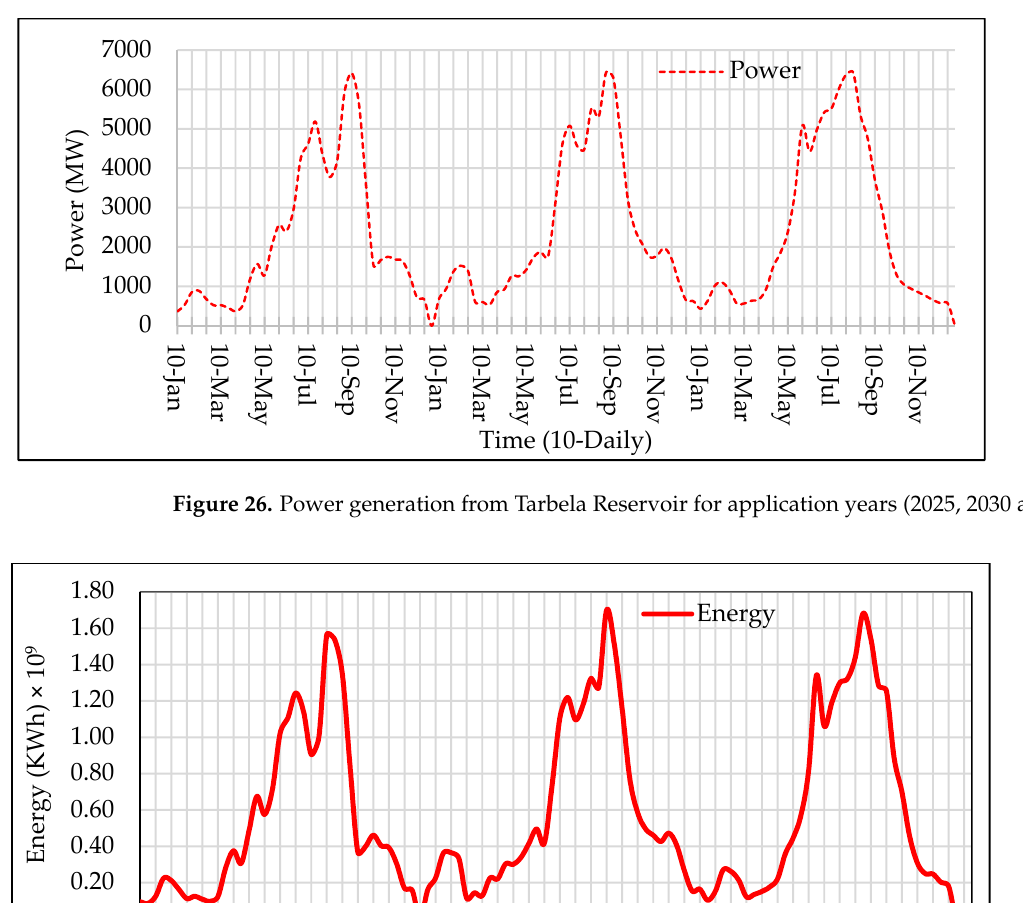
Figure 25. Irrigation releases from Tarbela Reservoir for application years (2025, 2030 and 2035).